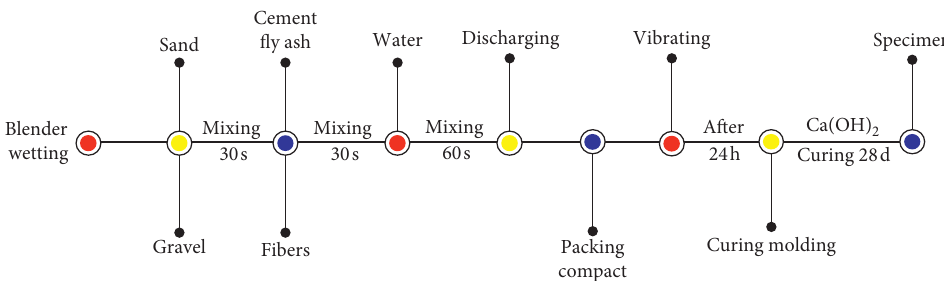
Figure 2: Concrete mixing